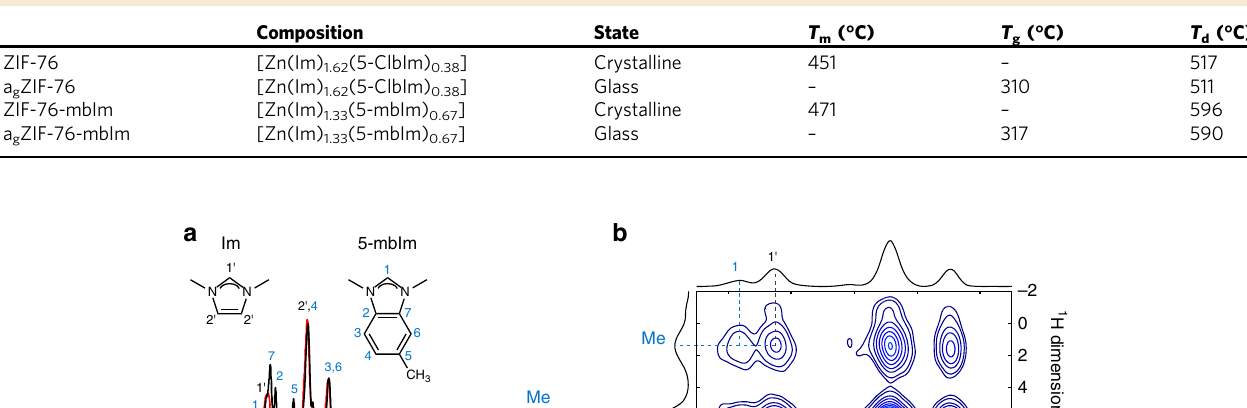
Table 1 Summary of the crystalline and glass